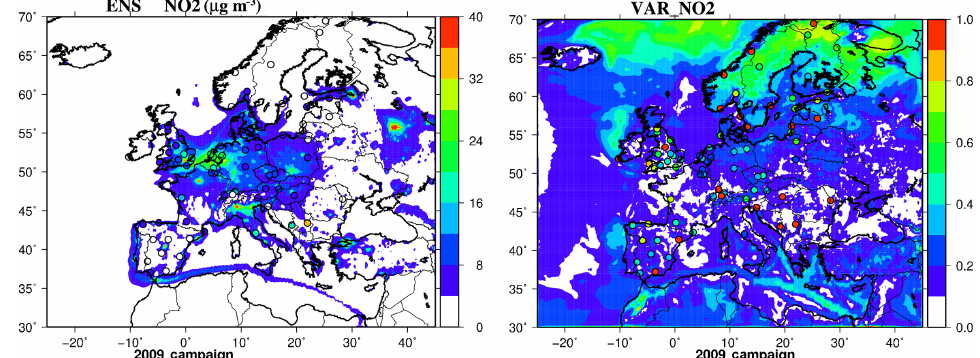
Figure 8. Left column: mean nitrogen dioxide concentrations (µgm − 3 ) of the ensemble (ENS) for the 2009 campaign with correspond- ing observations (coloured dots). Right column: coefficient of variation of models (no unit) constituting the ensemble with corresponding normalized root mean square errors of the ensemble (coloured dots). Red colour is assigned for values exceeding the colour